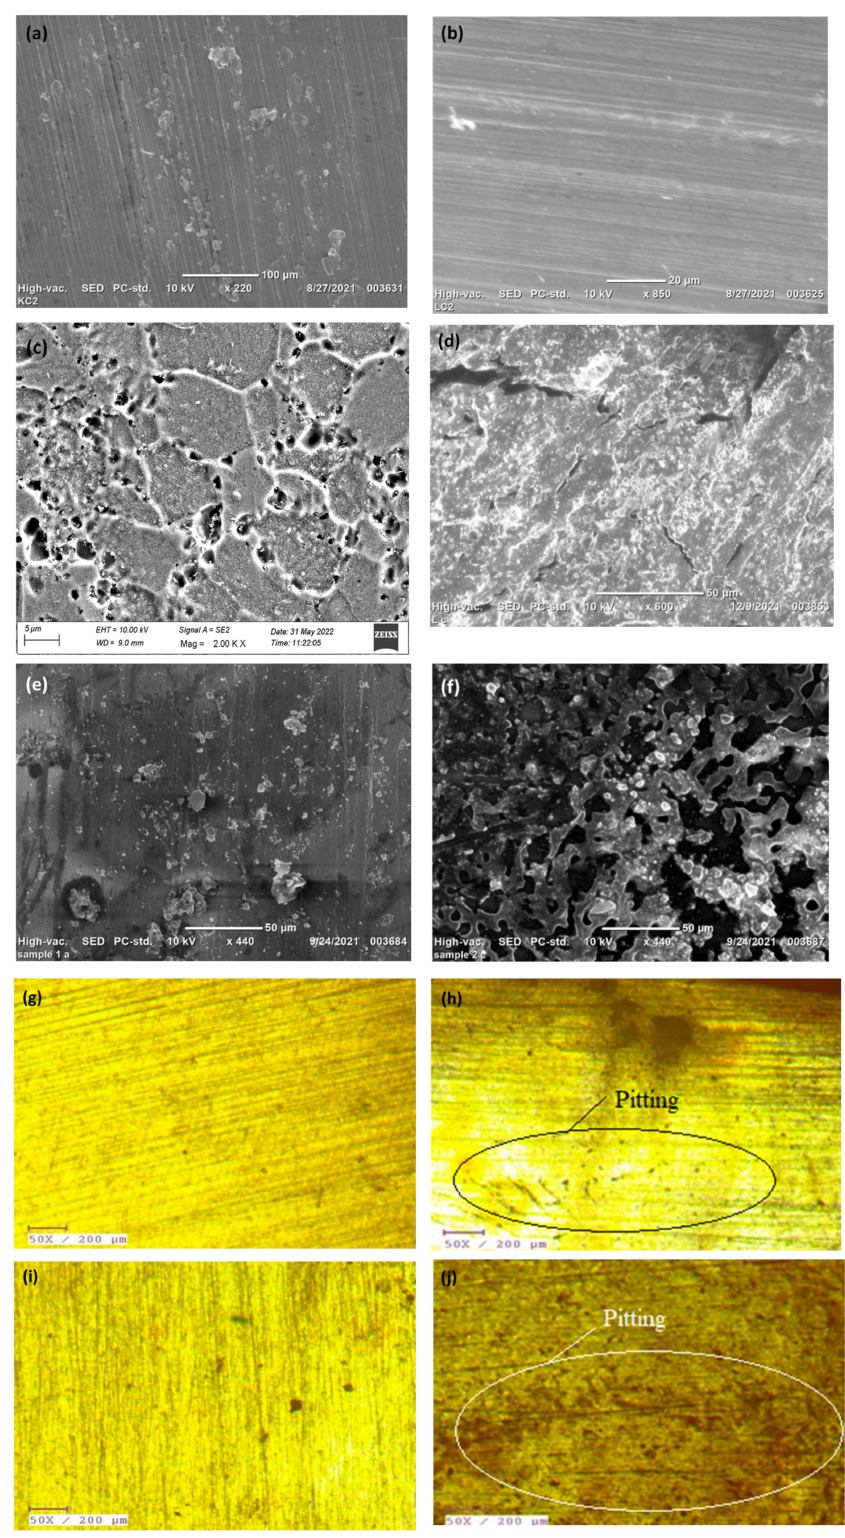
Figure 8. SEM micrographs ( a ) unetched 900-90 joint ( b ) unetched 900-110 joint ( c ) etched 900-90 joint ( d ) etched 900-110 joint ( e ) Corroded 900-90 joint ( f ) Corroded 900-110 joint ( g ) Optical microscopy image of 900-90 joint before corrosion ( h ) Optical microscopy image of 900-90 joint after corrosion ( i ) Optical microscopy image of 900-110 joint before corrosion ( j ) Optical microscopy image of 900-110 joint after